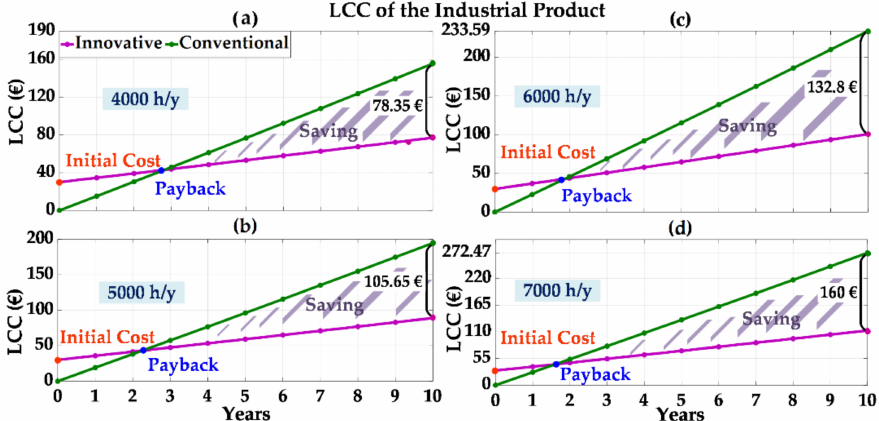
Figure 10. LCCA of the innovative industrial product regarding a ten-year period; ( a ) 4000 h/y, ( b ) 5000 h/y, ( c ) 6000 h/y, ( d ) 7000